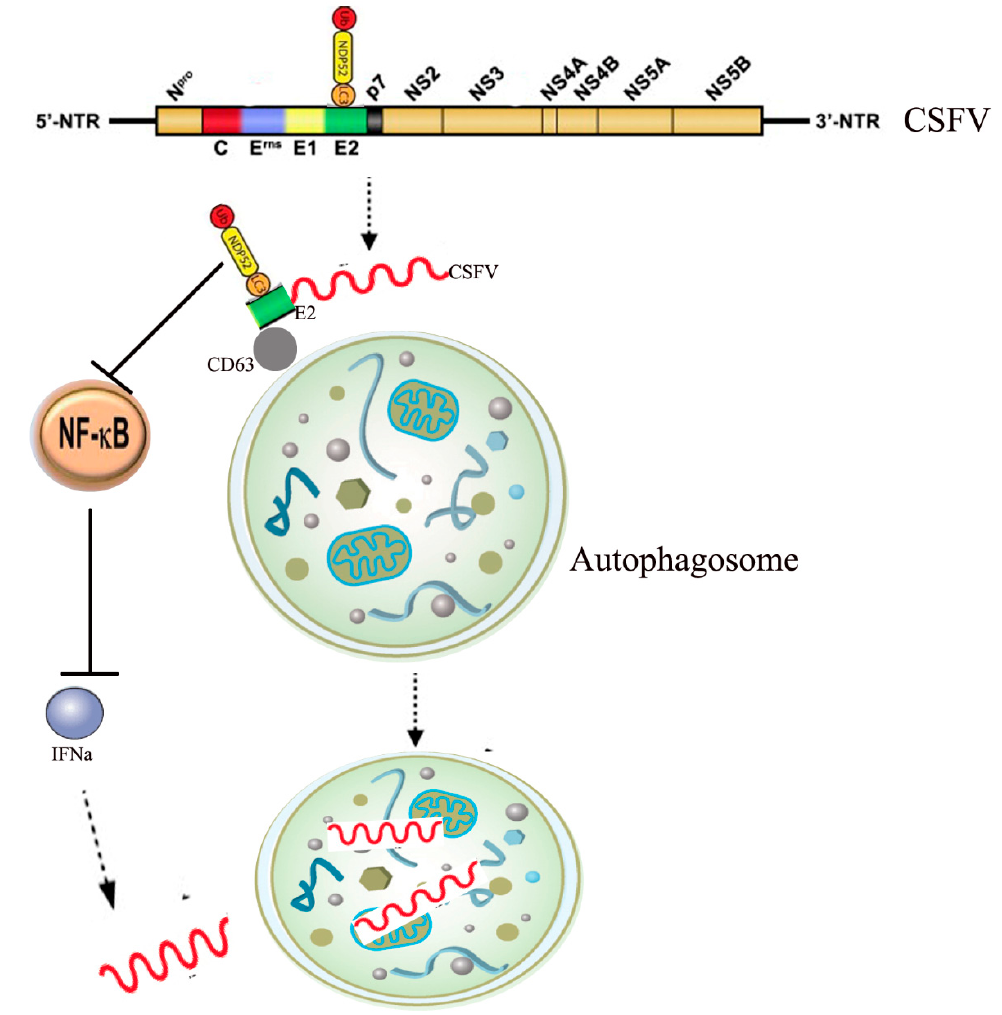
Figure 4. The mechanism of NDP52 in CSFV infections. In the CSFV infection PK-15 cells, NDP52 protein co-localized with CSFV E2 protein in the cytoplasm. Inhibition of NDP52 reduces the binding of E2 protein and lysosomal marker molecule CD63. The inhibition of NDP52 promotes the activation of the NF- κ B signaling pathway and promotes the release of cytokines such as IFN α , inhibiting CSFV replication (Arrow shape indicates next step, T shape indicates suppression). Table 2. Function of autophagy and NDP52 in virus infections.